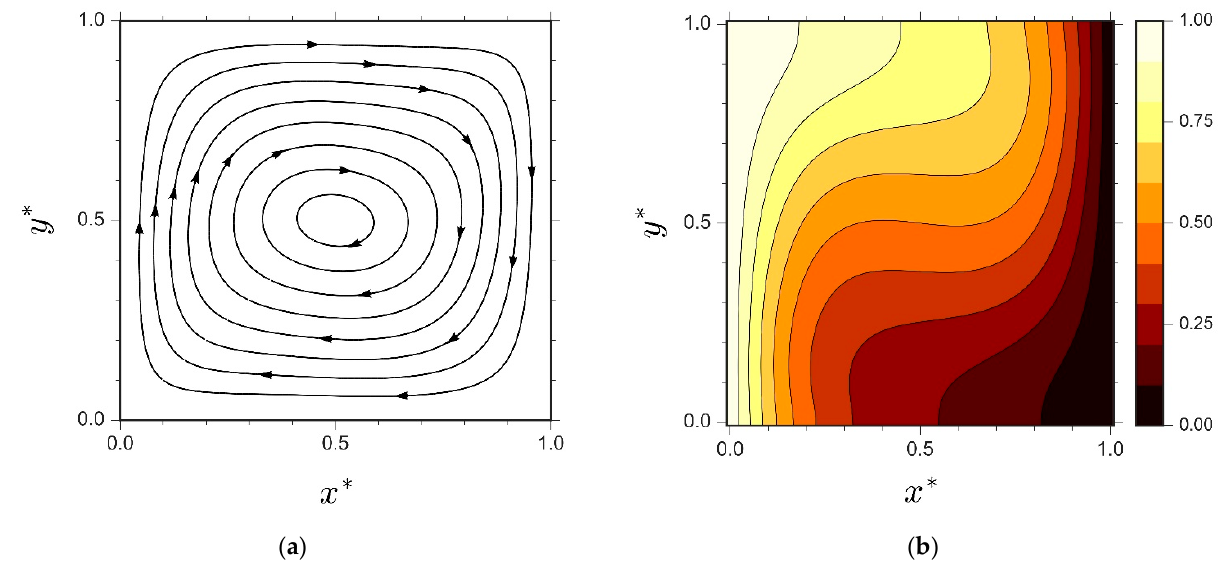
Figure 2. Steady-state flow characteristics of two-dimensional natural convection in a differentially-heated cavity for Ra = 10 4 , Pr = 0.71, τ υ = 0.6 and Ma = 0.1 from scenario IIB, displaying ( a ) Streamlines and ( b ) Isotherms contour.